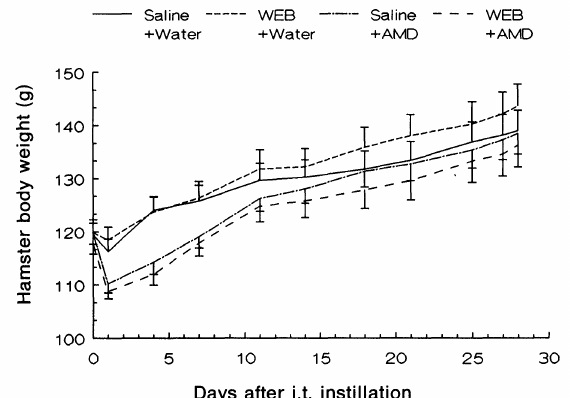
FIG. 1. Effects of intratracheal instillation of water or amiodarone (AMD) with or without treatment of WEB 2086 on body weight of hamsters. WEB 2086 (10 mg/kg) or an equivalent volume of saline was injected intraperitoneally once a day for 2 days prior to intratracheal instillation of AMD (1.5/mol/0.25 ml/100 g BW) or an equivalent volume of sterile distilled water and thereafter daily throughout the study. Hamsters were weighed twice a week and on the 28th day, the experiment was terminated. Each point represents the mean -I-S.E.M. of 12-14 animals in each group.